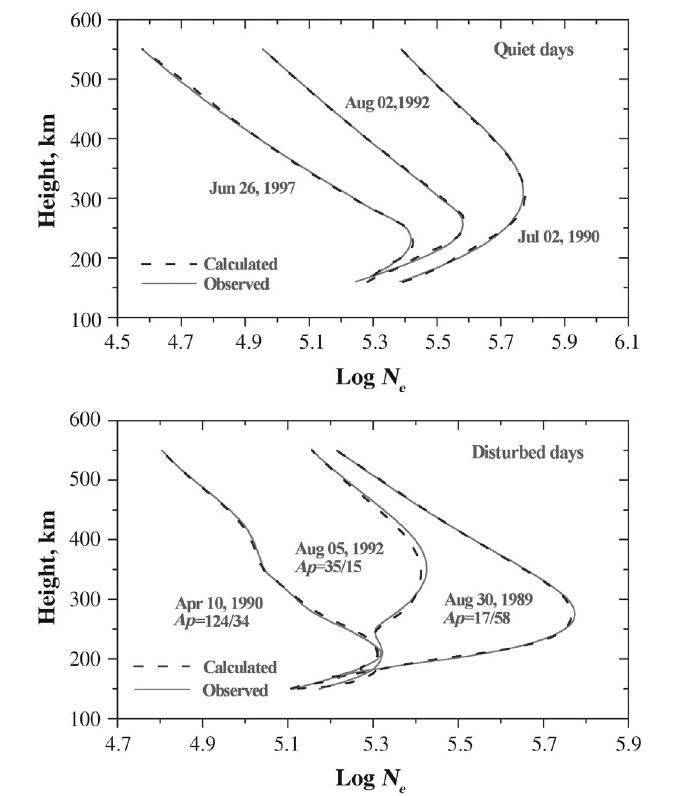
Fig. 4.4. Observed at EISCAT and calculated daytime N e ( h ) profiles for quiet ( top ) and disturbed ( bottom ) con- ditions. Profiles for different levels of solar activity (minimum, June 26, 1997; medium, August 02, 1992; and maximum, July 02, 1990, top panel) and different levels of geomagnetic activity are considered ( Ap indices for this and previous days are shown next to curves in the bottom panel). Note the variability of N e ( h ) profiles un- der disturbed